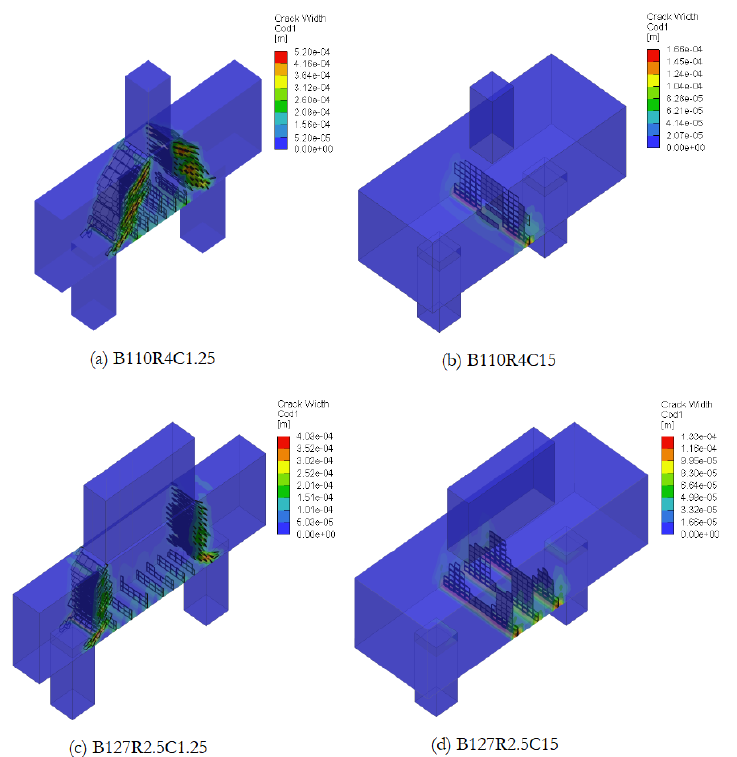
Figure 13. Internal cracking of models C1.25 (a) and (c) and models C15 (b) and (d), for the failure load of models